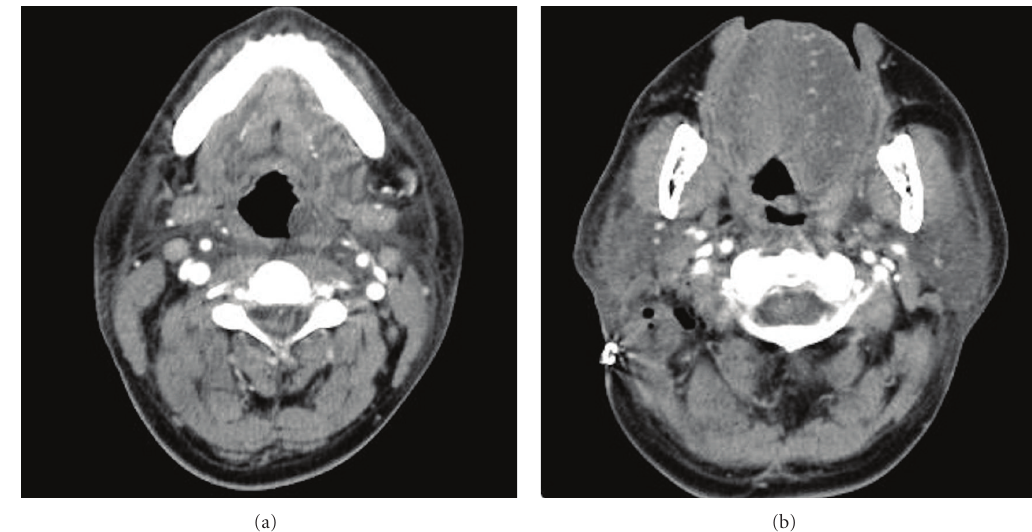
Figure 3: Postoperative contrast-enhanced computed tomography of the neck. Sixteen hours after the operation, swelling of the neck, tongue, pharynx, and vocal cords was observed on the left side.